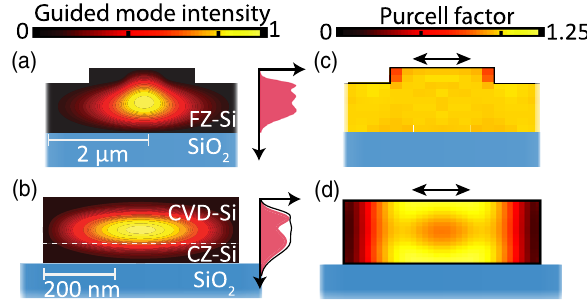
FIG. 1. Different waveguide geometries used in this work. (a) To confine a single guided mode (colors: intensity profile), rib waveguides are fabricated by partially etching a chip with a 2 μ m FZ ( > 10 k Ω cm) device layer (DL) on top of a 1 μ m buried oxide (BOX). Erbium is implanted at three different energies to give an approximately homogeneous concentration in the waveguide (red profile on the right). (b) Ridge waveguides are fabricated by fully etching a 0 . 2 μ m thin DL on a > 2 μ m BOX. The intensity profile (colors) shows the fundamental TE mode. The DL consists of CZ material ( > 1 Ω cm) or a 0 . 12 μ m pure CVD layer grown on top of a 0 . 07 μ m thin CZ seed. To achieve an approximately homogeneous concentration (right), three (CZ, black) or two (CVD, red) different implantation energies are used. (c) In the rib waveguides, the photonic local density of states (LDOS) and the associated Purcell factor in the silicon layer (colors) are inde- pendent of the dopant position in the waveguide, leading to an effective Purcell factor F P of 1 for all emitters. (d) In the ridge waveguides, the radiative decay rate of dipolar emitters oriented along the waveguide width (double arrow) is suppressed ( F P < 1 ) or enhanced, depending on its